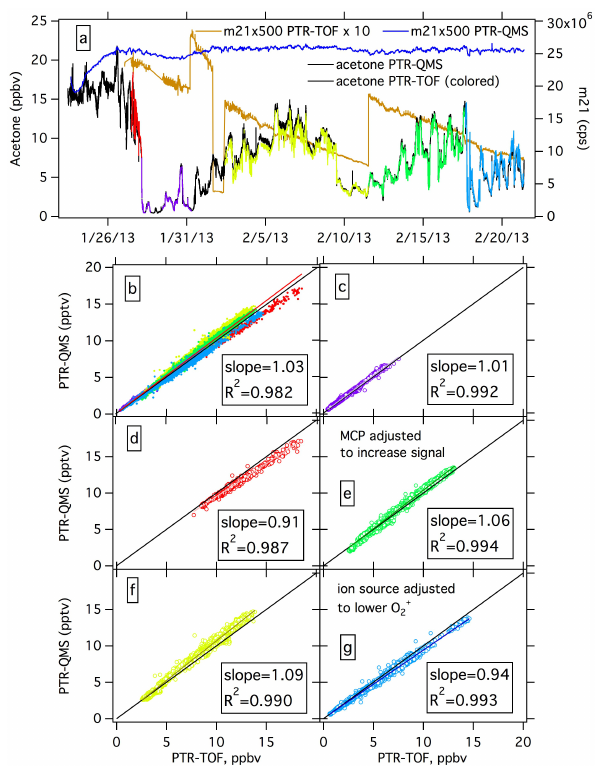
Figure 7. PTR-QMS and PTR-TOF acetone intercomparison dur- ing UBWOS2013: (a) time series of the PTR-TOF and PTR-QMS primary ions and acetone. The color code of the PTR-TOF acetone signal indicates when the PTR-TOF was relatively stable. (b) Scat- ter plot of PTR-QMS and PTR-TOF acetone for the whole cam- paign. (c – g) Scatter plots for separate stable periods of the PTR- TOF.